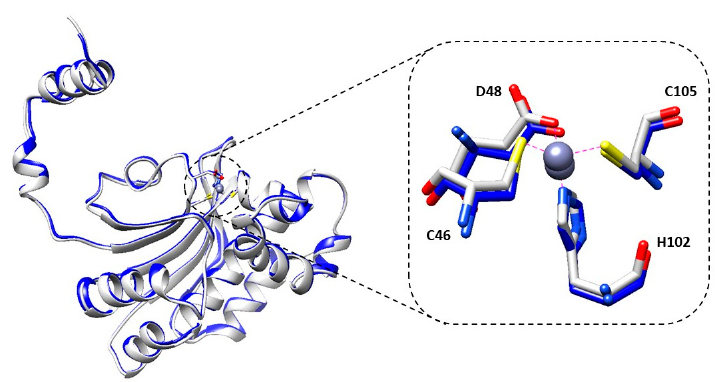
Figure 3 . A comparison of the Bps β CA active site arrangements in two different pH conditions: 7.5 and 8.5. In gray: Bps β CA crystalized at pH 7.5. In blue: Bps β CA crystalized at pH 8.5 .